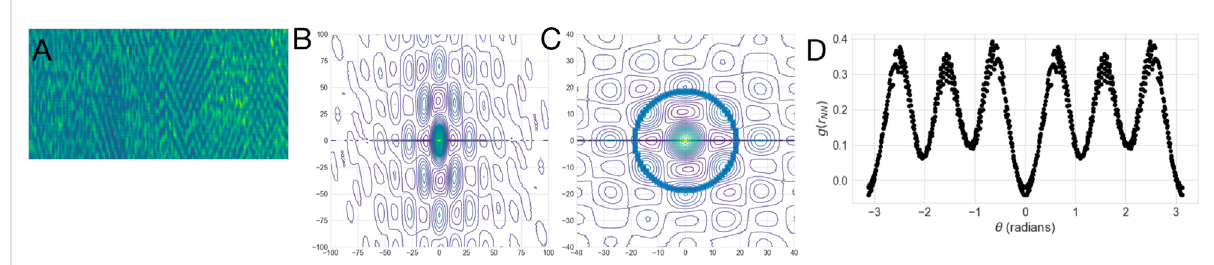
FIGURE 14 (A) Example kymograph showing moderate hexagonal ordering. (B) Two-dimensional autocorrelation of (A) , with the central region used to determine the peak widths highlighted. (C) 2D autocorrelation with vertical distances rescaled so that the central peak is circularly symmetric. The ring represents points whose distance from the origin is equal to the expected average inter-particle spacing. (D) Intensity as a function of angle for the ring of points identi fi ed in (C) , resulting in a C 6 with magnitude 0.36 and angle 0.03